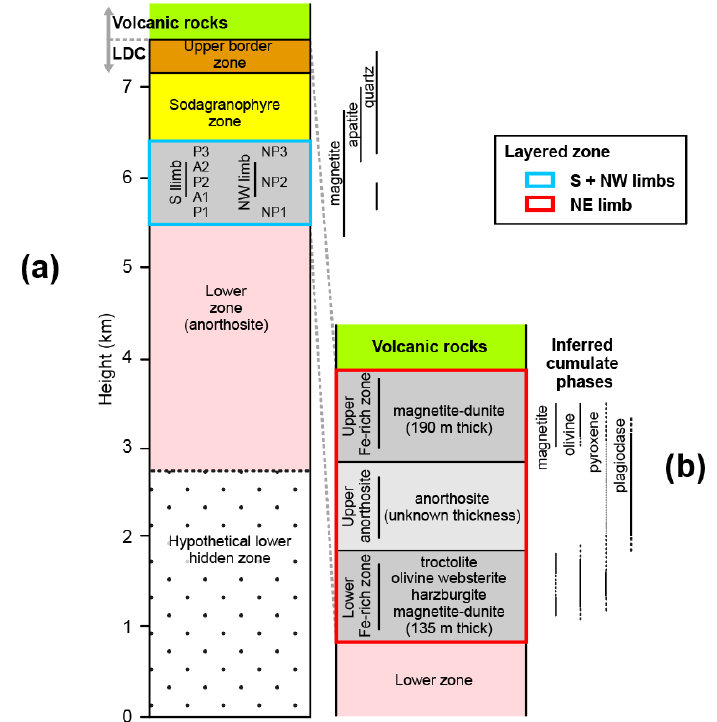
Figure 2. Stratigraphic column of the Lac Doré Complex (LDC) showing the units observed in ( a ) the NW and S limbs of the LDC [1] and ( b ) in its NE limb [5].